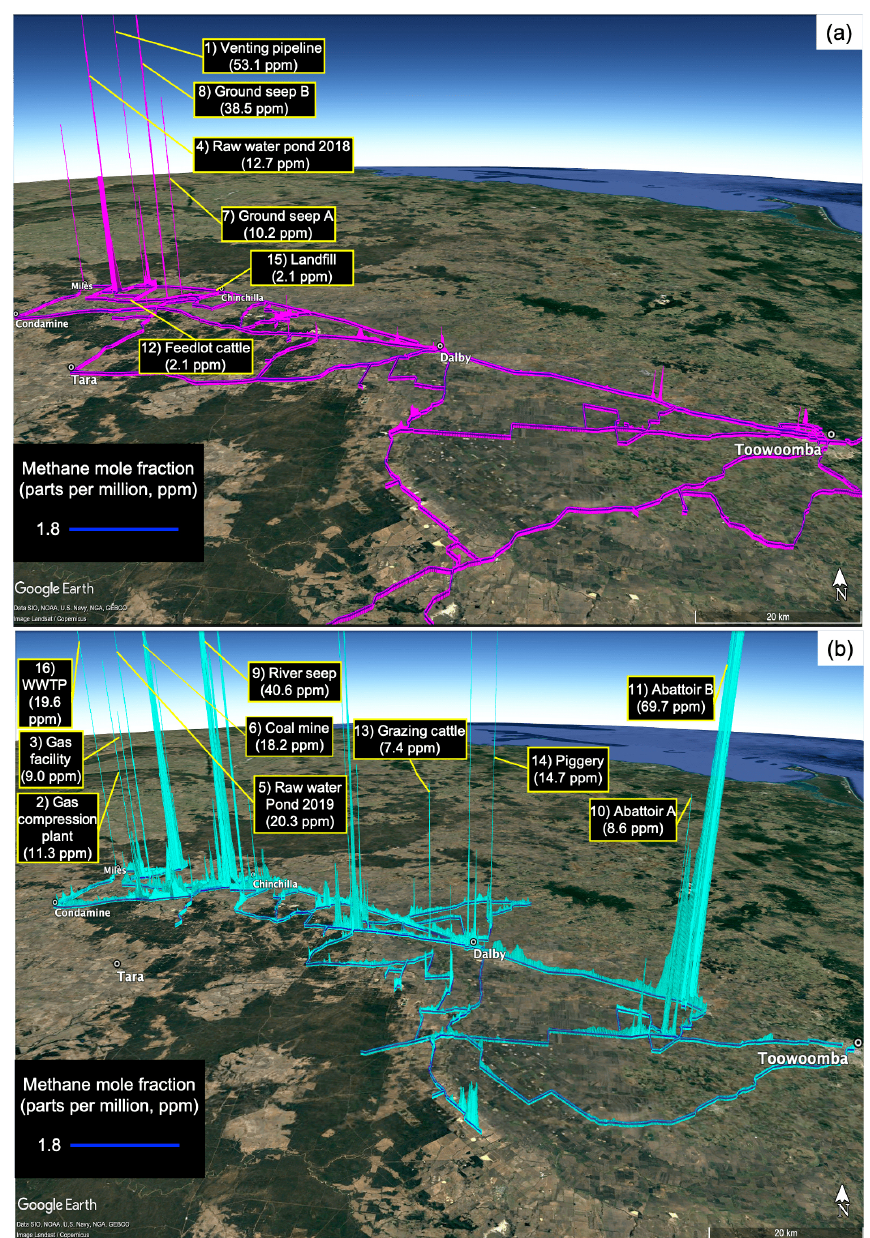
Figure 2. The vehicle-mounted CH 4 survey routes throughout the Surat Basin. Daytime measurements are represented by a magenta ribbon and nighttime measurements by a cyan ribbon. A linear scale is used to represent the measured CH 4 mole fraction. For all sampled plumes, the highest recorded CH 4 mole fraction is indicated (image ©Google